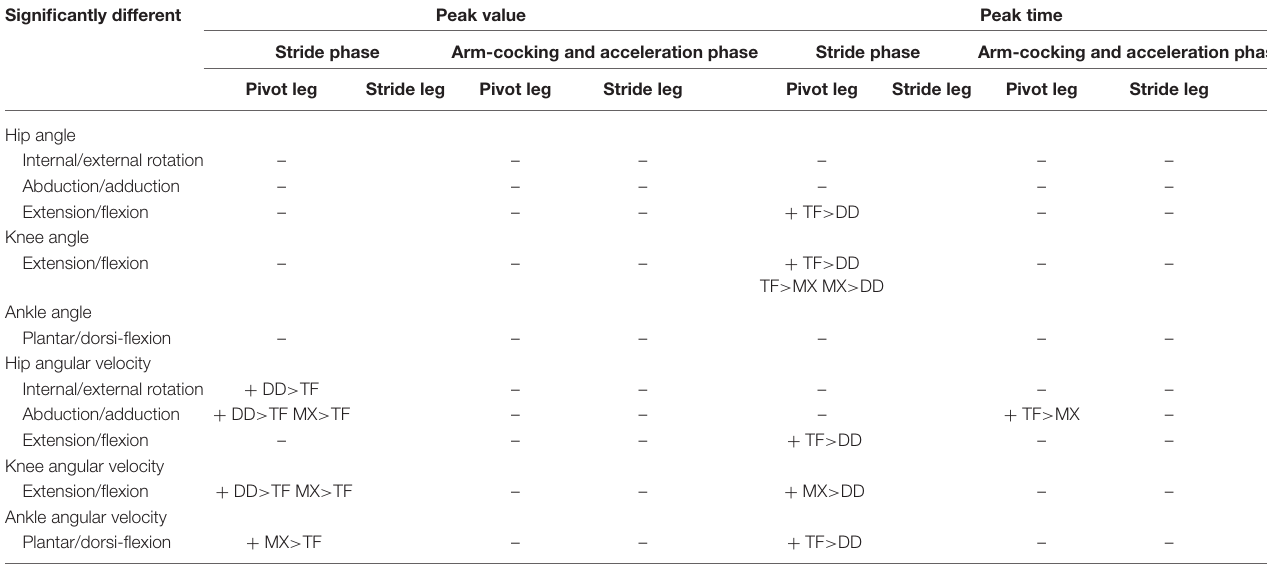
TABLE 4 | Statistical summary of joint angle and joint angular velocity during the stride and arm-cocking and acceleration phases. Significantly